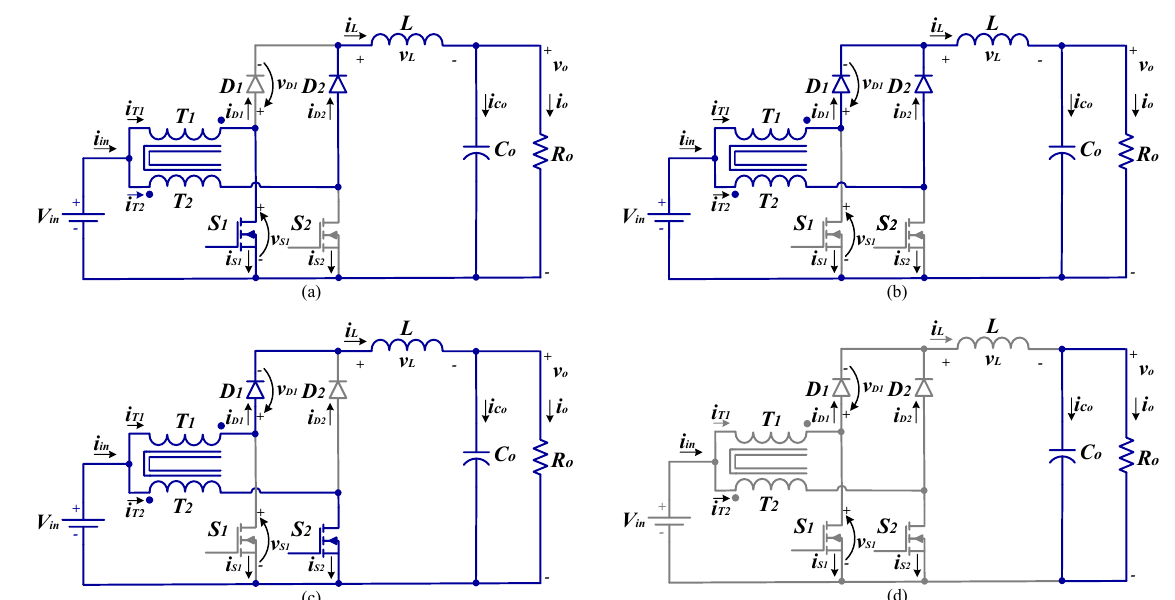
Figure 1. Equivalent circuits of the operation stages of 3SSC-A-based boost: ( a ) First mode. ( b ) Second mode. ( c ) Third mode. ( d ) Fourth